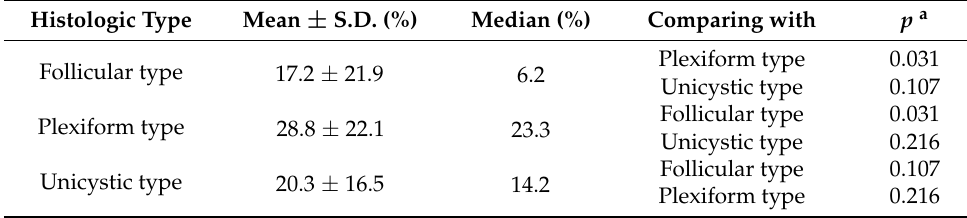
Table 4. Comparison of expression status of SOX2 in three types of